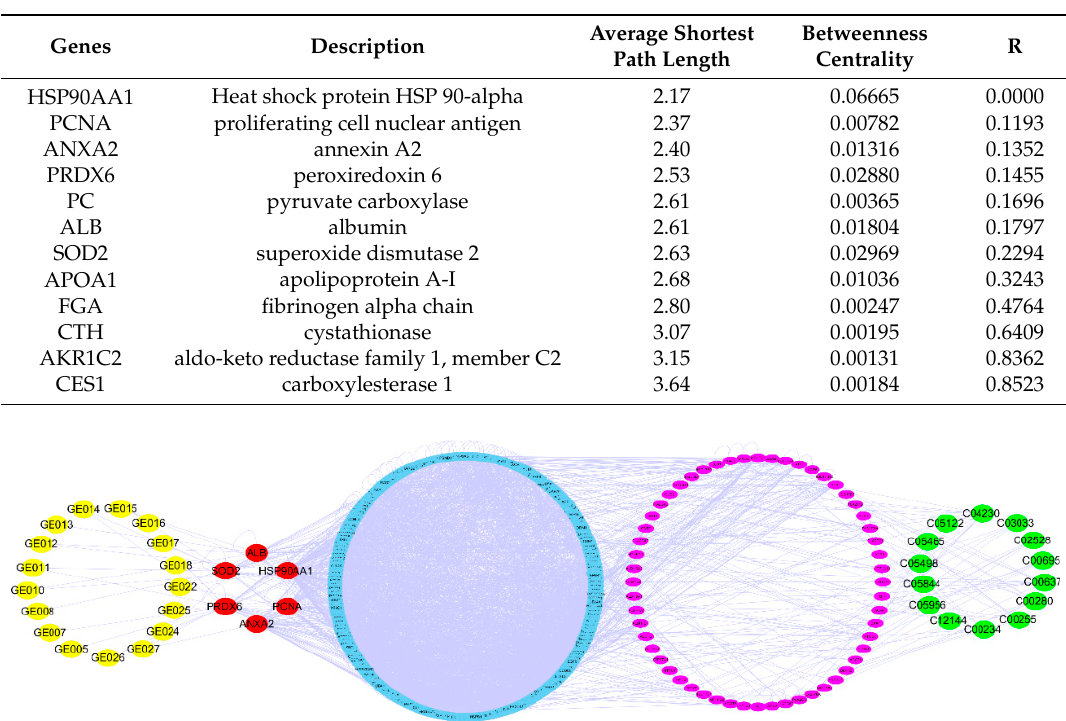
Table 3. 12 intersection targets with average shortest path length and betweenness centrality.